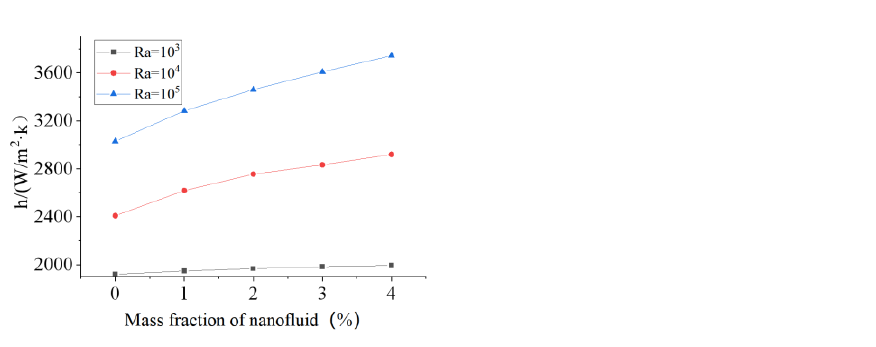
Figure 6. The geometry of microchannel with discrete heat sources ( a ), the temperature distribution in microchannel ( b ) and the flow velocity induced by heat sources ( c ) for q = 10 6 W/m 2 , initial mass fraction 4.0 wt%, initial temperature of fluids and walls 300 K.